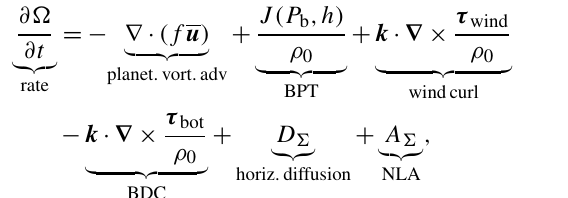
branch is redirected southward. This second branch is rela- tively intense in our simulation but is also present in ANDRO data (Fischer et al., 2018, their Figs. 3 and